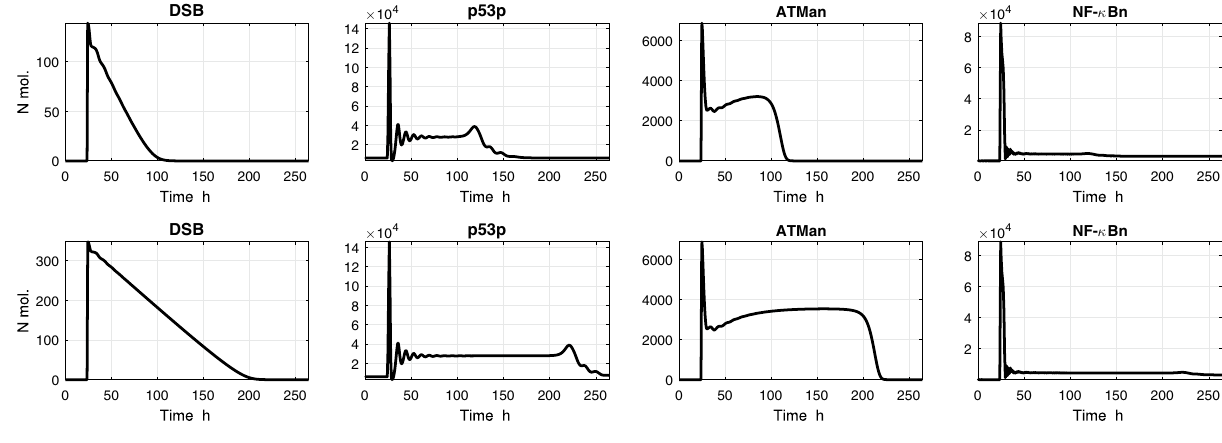
Figure 2. Time courses of selected variables in the the ATM/p53/NF- κ B signaling pathway model described in Jonak et al. 12 . Simulation was performed with two input signals: (TOP PANELS) 10 ng/ml TNF and 4 Gy IR; (BOTTOM PANELS) 10 ng/ml TNF and 10 Gy IR. TNF stimulation is constant during the simulation, IR radiation is turned on after 24 h simulation for 1 h.